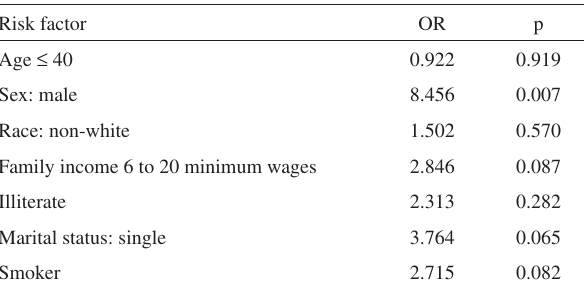
Table 4 - Results of logistic regression analyses for patients identified as alcoholics by the medical